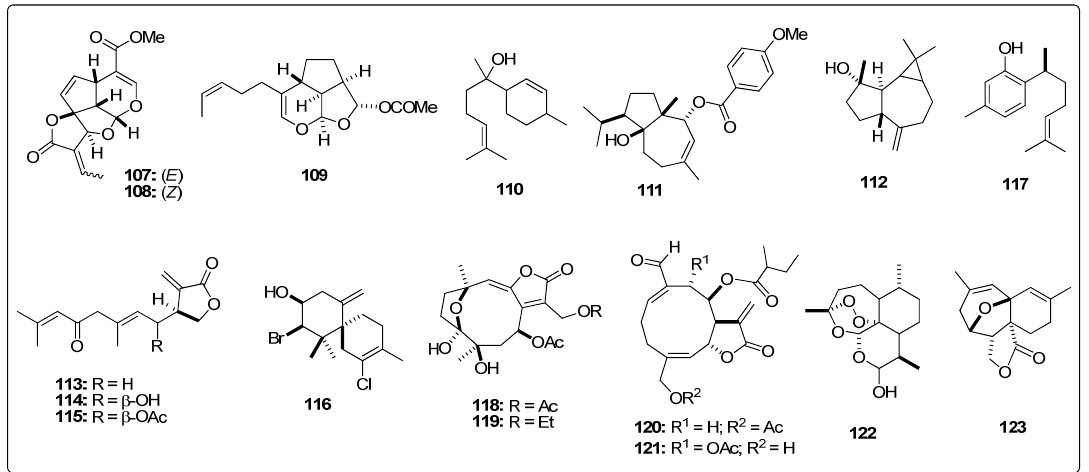
Figure 9. Structures of the tested miscellaneous sesquiterpenes